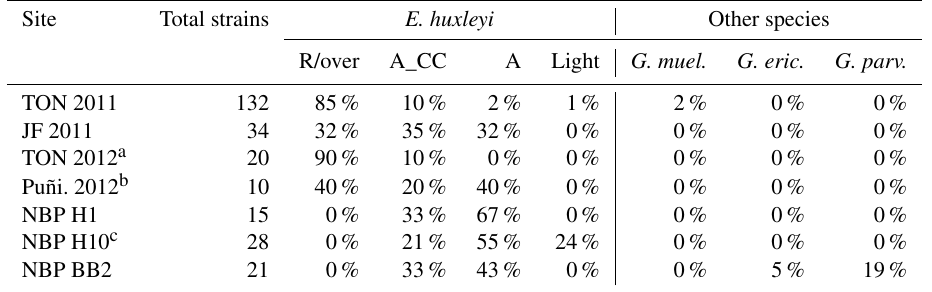
Table 1. Noelaerhabdaceae strains isolated during this study. All sites near Tongoy were grouped in 2011 and in 2012, as were the sites at JF in 2011.